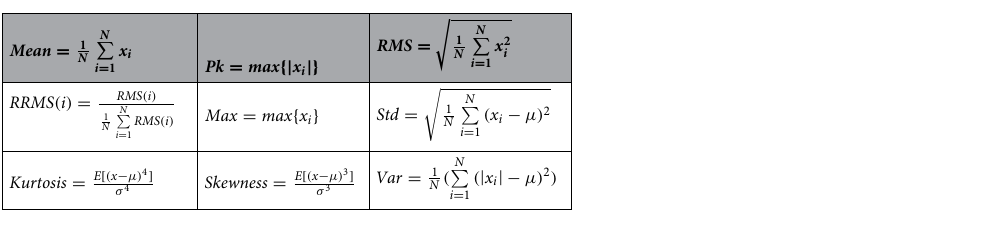
Table 2. Time domain